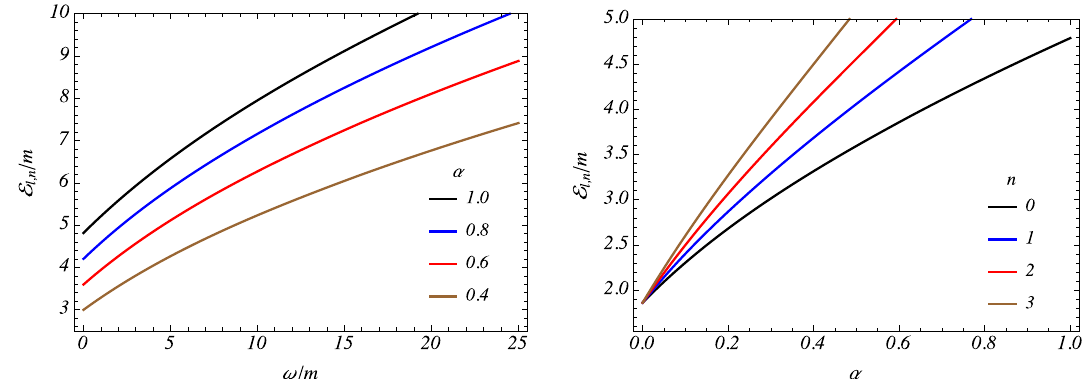
Fig. 5 Positive energy profile of the DO subject to the MIT bag boundary condition as function of ω/ m (left plot) and α (right plot). In the left plot we have different values of α and n = 1, while in the right plot we consider ω/ m = 2 . 5 and different energy levels. In both plots we have mr 0 = 2 . 5 and κ = 5 / 2